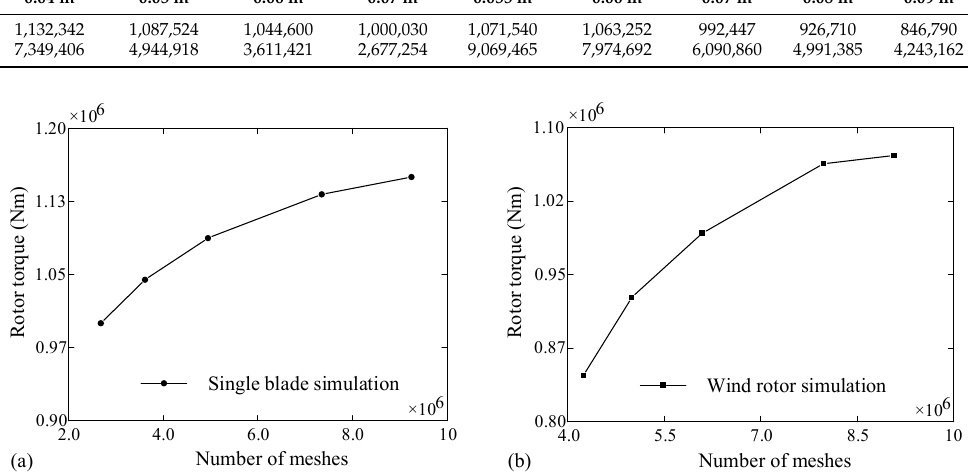
Figure 11. Rotor torque calculation results under different mesh numbers. ( a ) Single-blade simulation; ( b ) Wind rotor simulation. Table 4. Results of mesh sensitivity analysis.